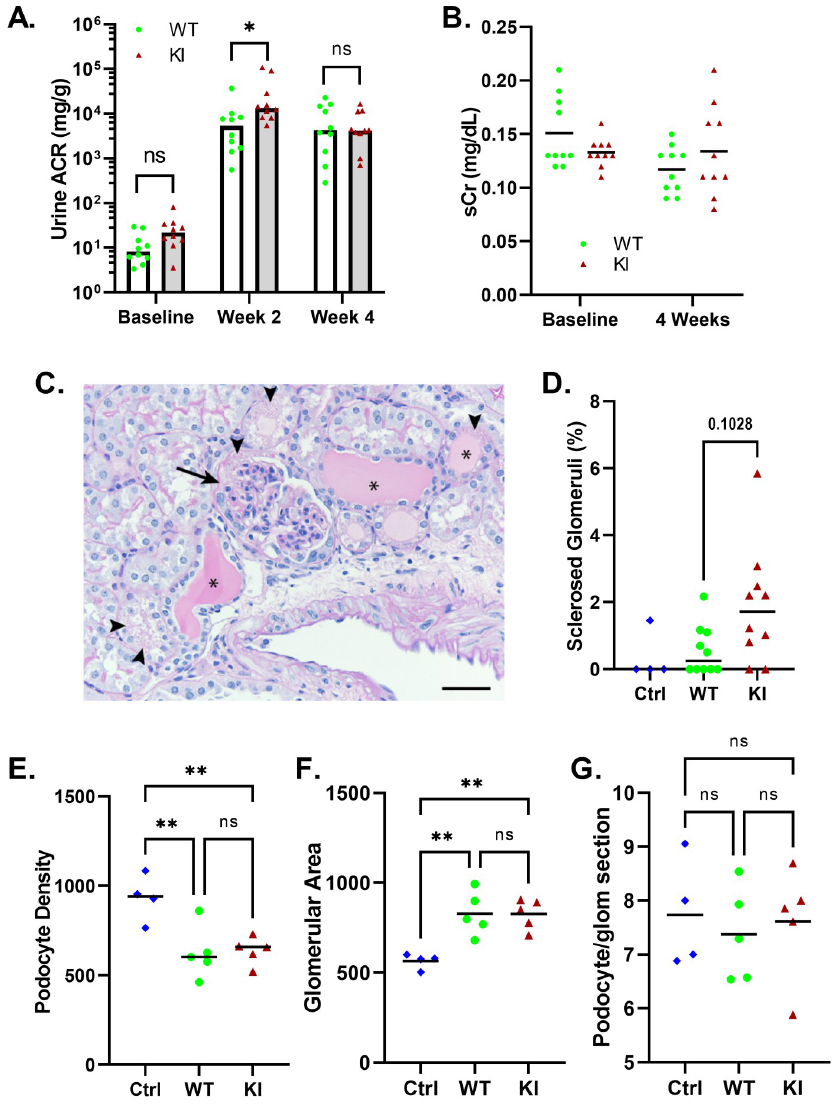
Fig 3. Effect of Trpc6 genotype on glomerular response to angiotensin II infusion. Wild-type and Trpc6 E896K/E896K (KI) male mice were subject to ATII infusion for 4 weeks. A, urine albumin-to-creatinine ratio (ACR) measurements demonstrate development of robust albuminuria in both groups. KI mice developed slightly greater albuminuria at 2 weeks compared to wild-type, an effect that did not persist at 4 weeks. Shown are median and individual values; n = 10/ group. Log-transformed ACRs were compared between genotypes by two-way ANOVA with Sidak’s multiple comparisons test. B, serum creatinine measurements at baseline and after 4 weeks of ATII infusion. Shown are mean and individual values; n = 10/group; no statistically significant differences between genotypes. C, example of renal pathology in a KI mouse after ATII infusion. Shown is a PAS stained section demonstrating a segmental glomerular lesion (arrow), tubular atrophy with cystic changes and proteinaceous casts (asterisks), and protein reabsorption droplets (arrowheads). Scale bar represents 20 μ m. D, percentage of glomeruli showing evidence of segmental lesions in control wild-type males (Ctrl; n = 4), and wild-type (WT) and Trpc6 E896K/E896K (KI) males subjected to ATII infusion (n = 10 each). Shown are median and individual values; differences between groups did not reach statistical significance by Kruskal-Wallis test with Dunn’s multiple comparisons. Glomerular podocyte density (E), glomerular area (F), and podocyte number per glomerular cross-section (G) were measured. Shown are mean and individual averages per animal in untreated control animals (Ctrl; n = 4) and ATII treated wild-type and knock-in animals (n = 5 each). 20 glomeruli were measured per animal. One-way ANOVA analysis with Tukey’s multiple comparisons test.